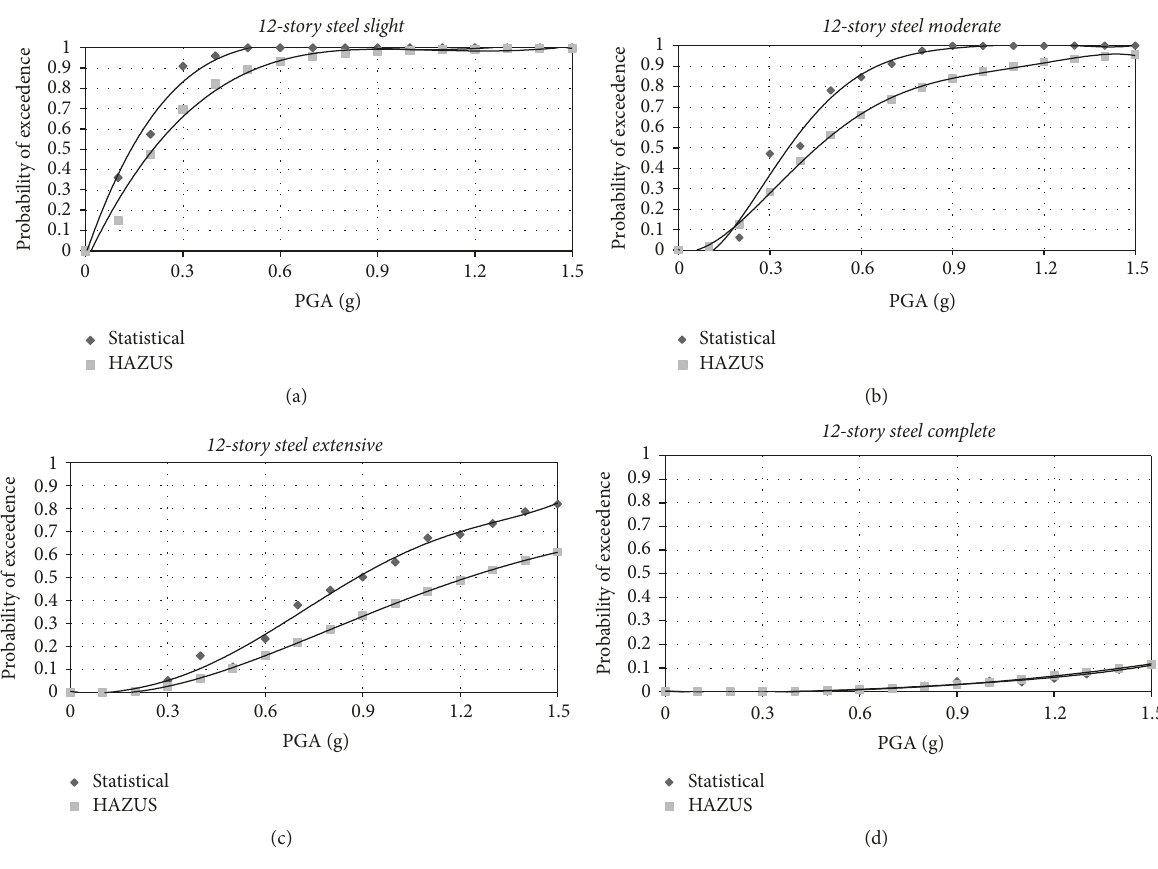
Figure 17: The fragility curves for the 12-story steel frame